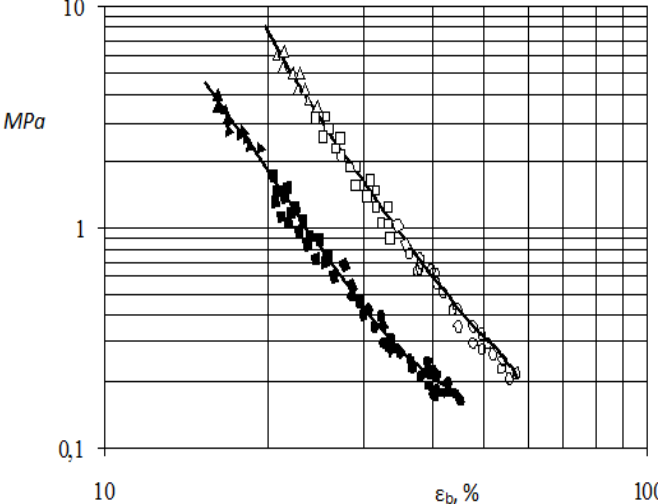
Figure 2: Envelopes by points of destruction [ σ (black symbols) silica three fraction (white symbols) of